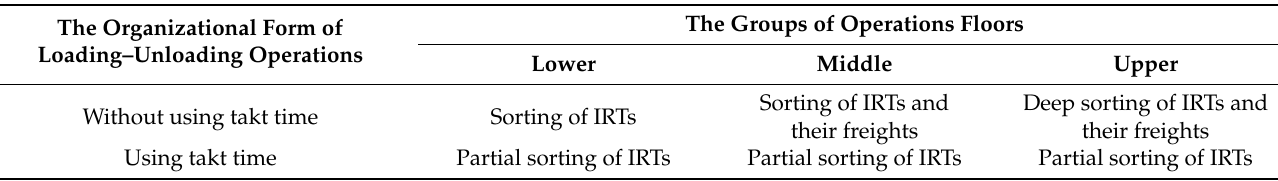
Table 2. Organization of loading–unloading operations in the CLN4.0, without using of takt time and using of takt time. The Organizational Form of Loading–Unloading